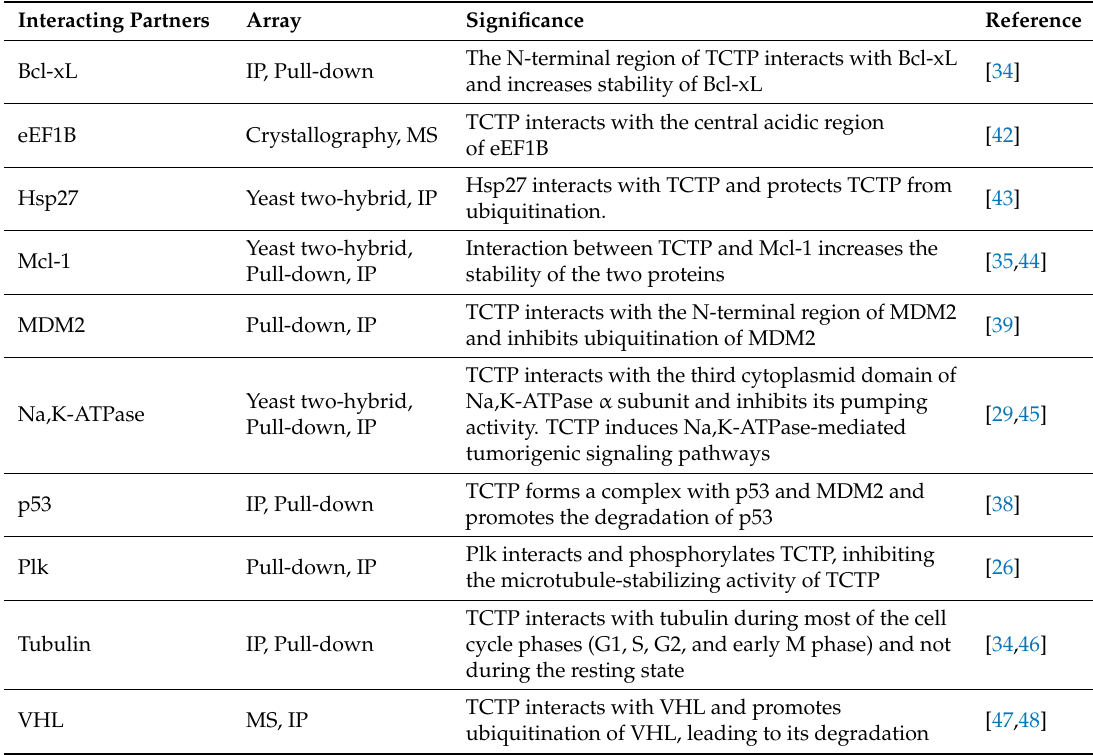
Table 1. Translationally controlled tumor protein (TCTP) interacting